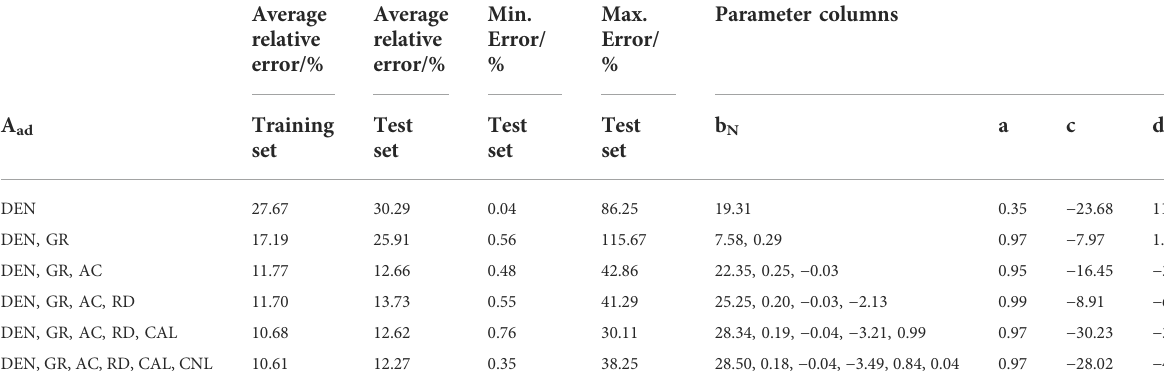
TABLE 2 Performance and parameters of the A ad content prediction models under different logging curves.